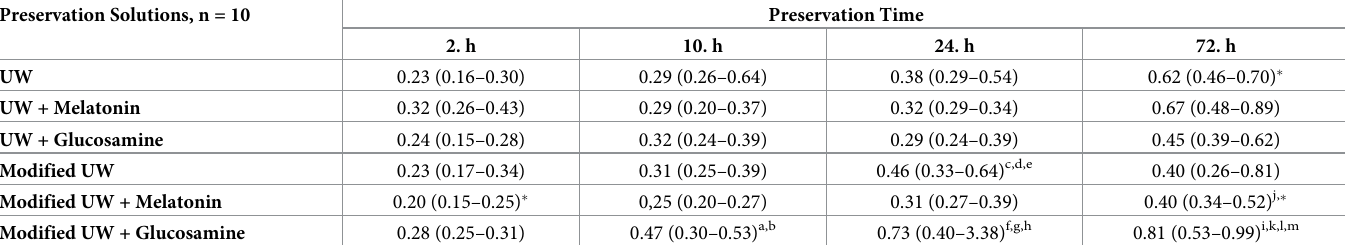
Table 4. Protein concentration (mg/g wet tissue) was measured from six different preservation solutions at 2, 10, 24, and 72 h of preservation time. Data are given as median and interquartile range (IQR). Preservation Solutions, n =